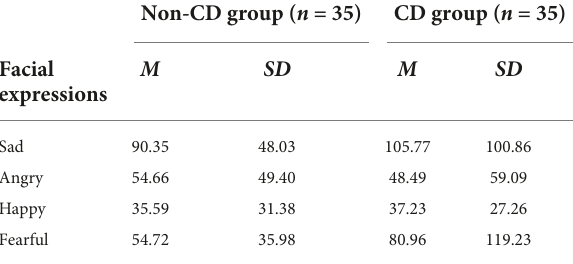
TABLE 4 The average reaction time (RT)s in delayed-match-to-sample (DMTS) task (ms).